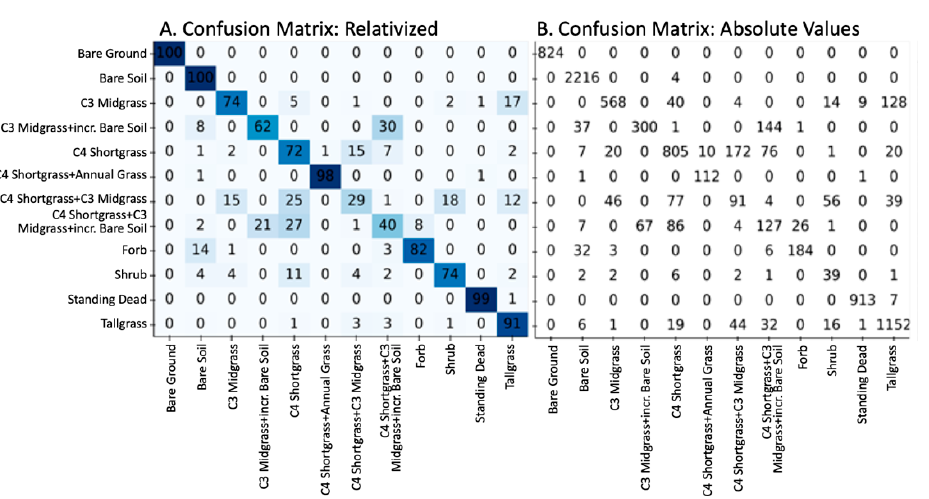
Figure 5. Confusion matrices showing the relative ( A ) and absolute ( B ) results of the SVM model using the validation (hold-out) data. Rows are the actual values, and the columns are the predicted values. Table 3. A detailed accuracy assessment for each plant community class showing the precision, recall, and F1-Score for each